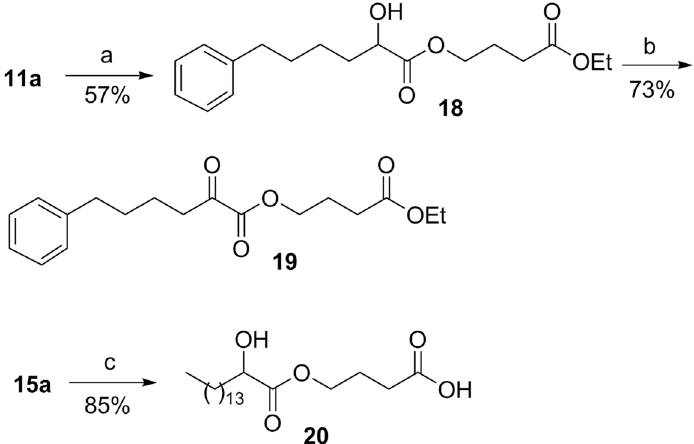
Figure 5. Synthesis of compounds 19 and 20 . ( a ) i. 20% aq. sol. Cs 2 CO 3 , THF, H 2 O, ii. BrCH 2 CH 2 CH 2 COOEt, DMF, reflux overnight; ( b ) Dess-Martin periodinane reagent, dry CH 2 Cl 2 ; ( c ) 50% CF 3 COOH in CH 2 Cl 2